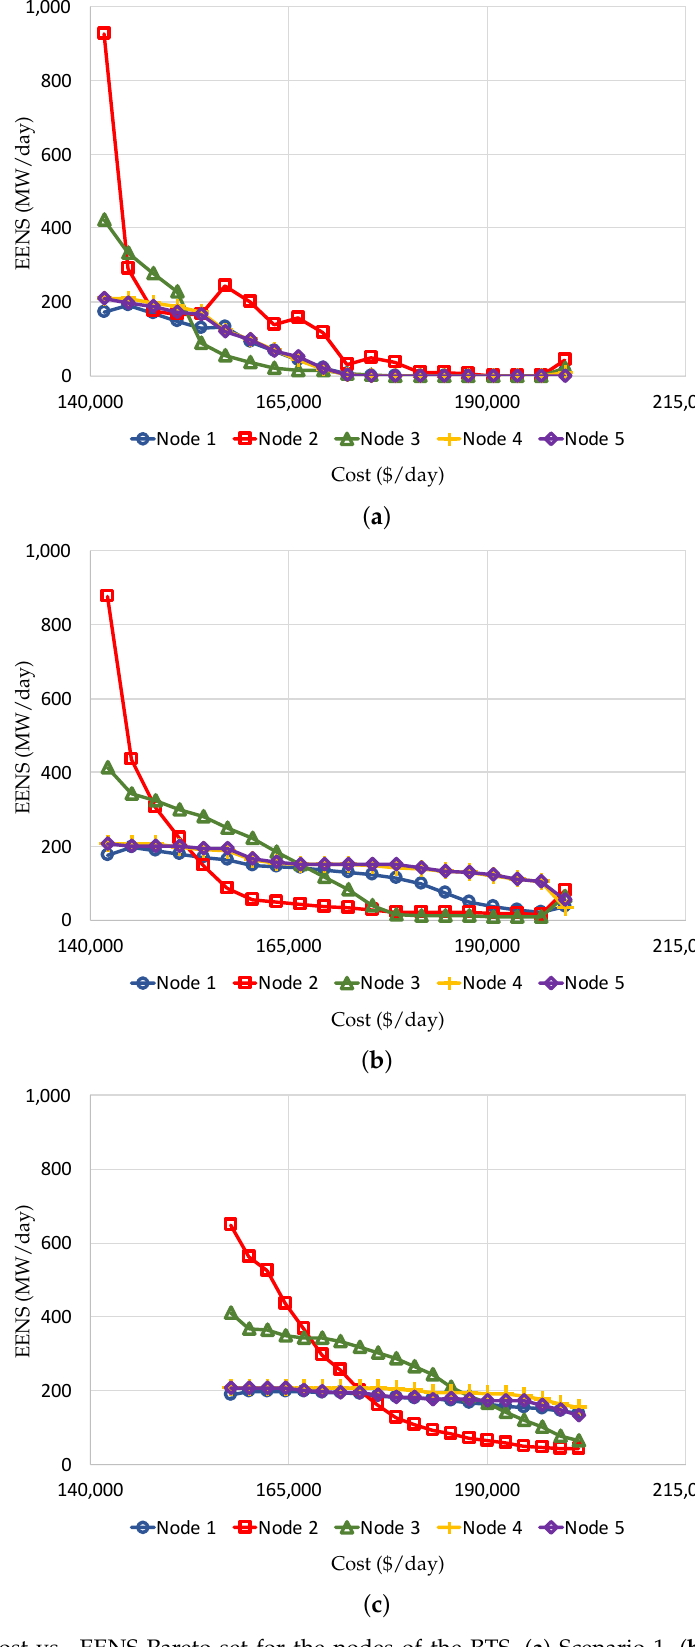
Figure 7. Cost vs. EENS Pareto set for the nodes of the RTS. ( a ) Scenario 1, ( b ) Scenario 2, and ( c ) Scenario